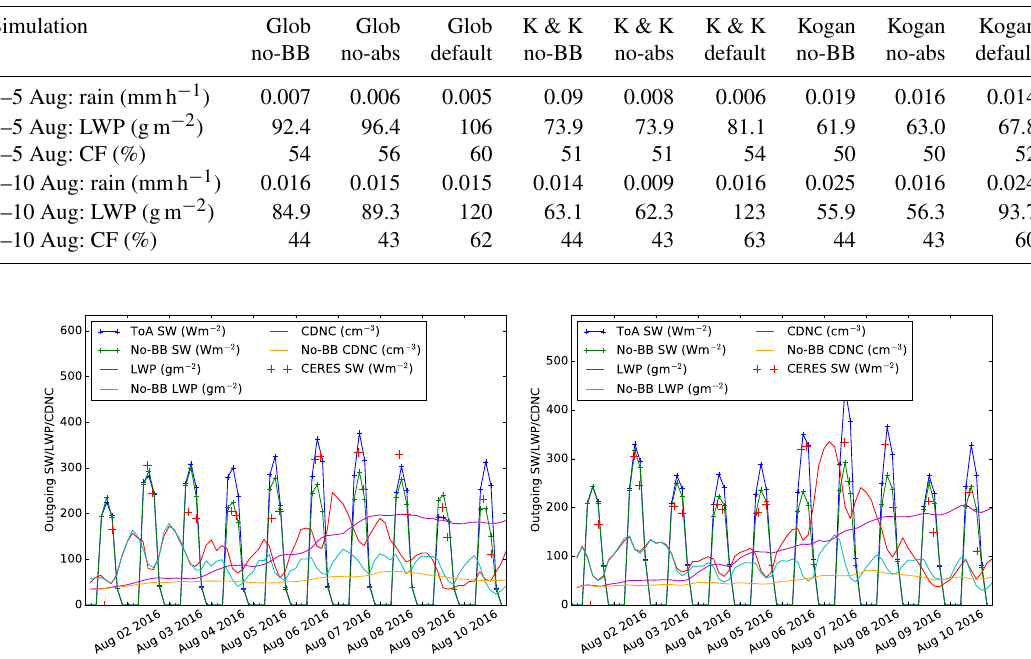
Figure 15. Outgoing shortwave flux at top of atmosphere (“ToA SW”) in the baseline model and a model version without biomass burning emissions (“No-BB”), for the regional domain in the global model on the left and the regional model on the right. CERES domain-mean observations are shown on the figures in red crosses. The changes to CDNC and LWP across the 10 days are also shown.